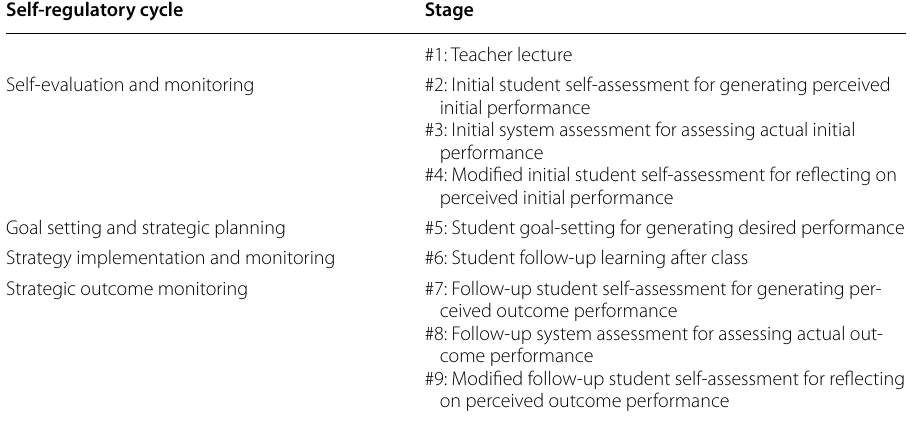
Table 1 Stages of learning activities and system support based on self-regulatory cycle Self-regulatory